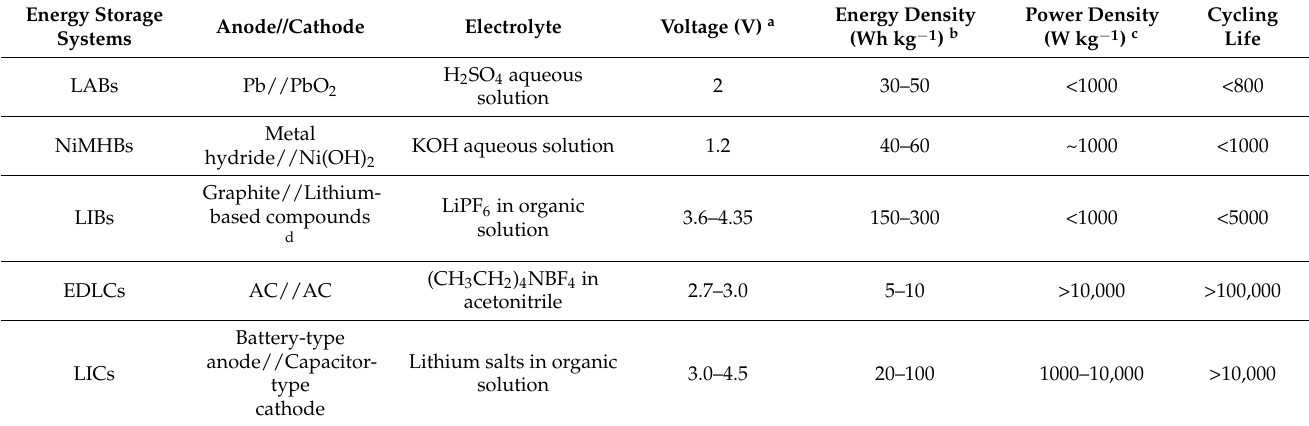
Table 1. The electrochemical performances of various energy storage